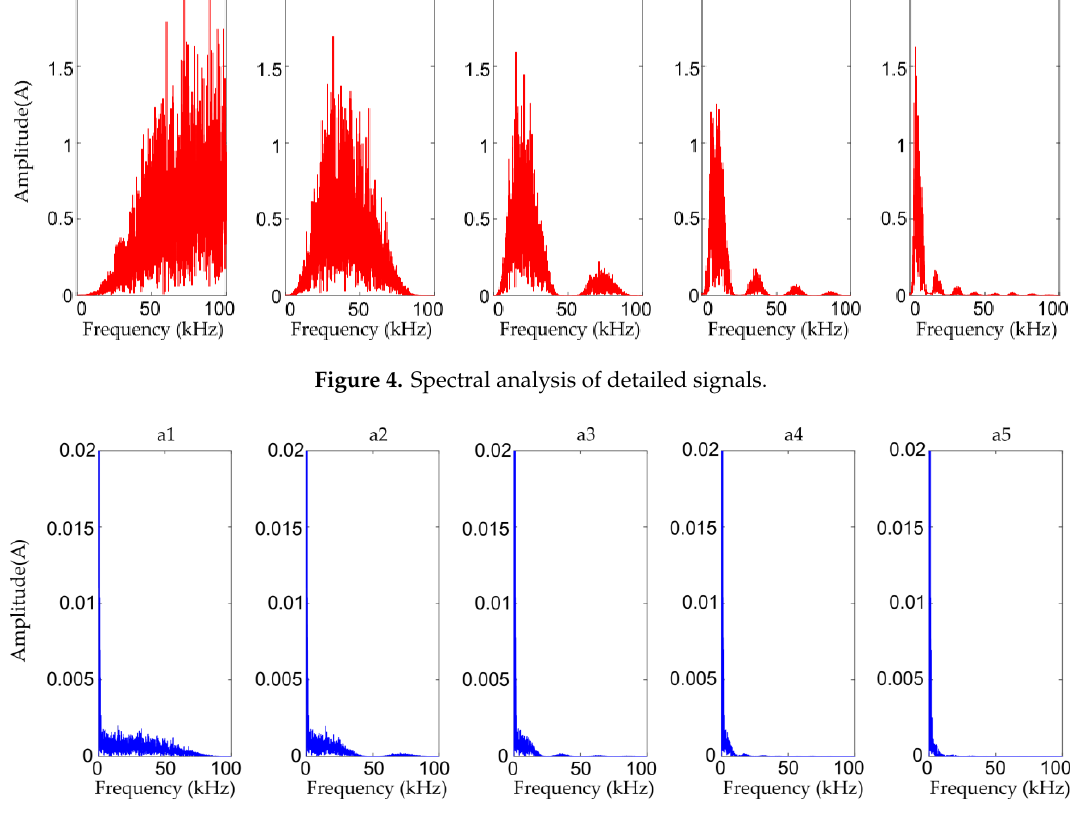
Figure 5. Spectral analysis of approximate